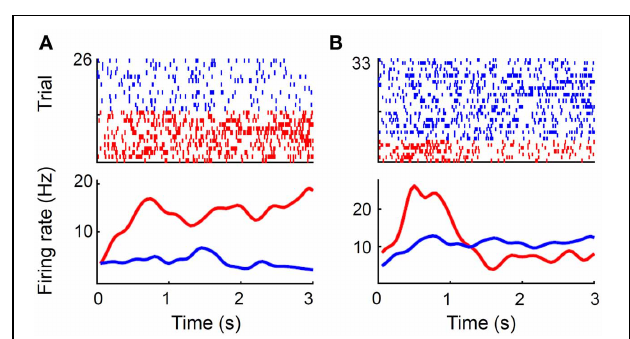
FIGURE 9 | Comparison of neural activity related to the previous and upcoming goal choices. The graphs show the number of neurons whose activity is better explained by the animal’s previous than upcoming goal choice (Equation 2 vs. Equation 3; 1-s window advanced in 50-ms steps). The dashed horizontal line indicates equal distribution (50%). The first data point of the left graph (time from delay onset) corresponds to the first 1s of the delay period, and the last data point of the right graph (time from delay offset) corresponds to the last 1s of the delay period. Asterisks indicate significant difference from chance level ( χ 2 -test, p < 0 . 05).